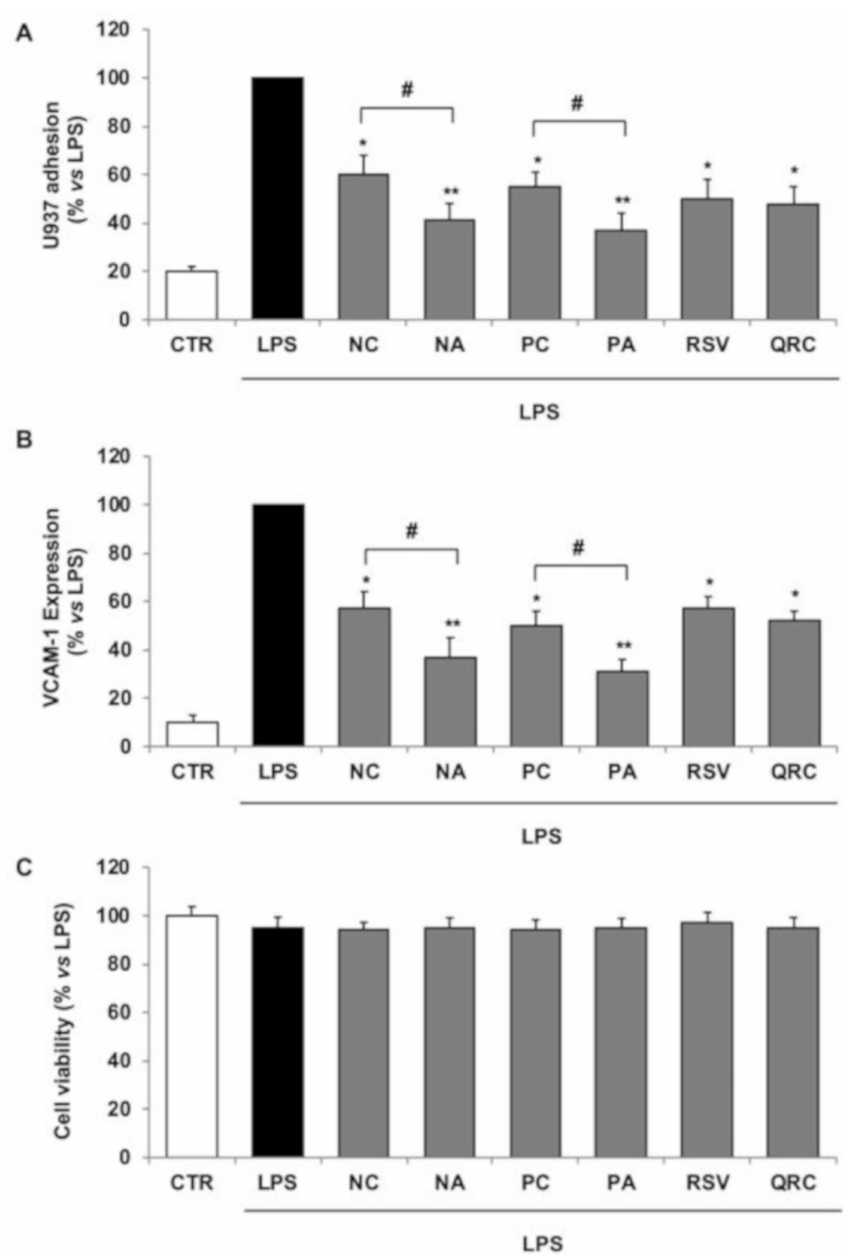
Figure 2. E ff ects of wine polyphenolic extracts or pure polyphenols on endothelial–monocyte adhesion and VCAM-1 expression. HMEC-1 were incubated with blend polyphenolic extracts (NC, PC, NA, PA) (10 µ L), pure polyphenols (resveratrol, RSV; quercetin, QRC) (10 µ mol / L), or vehicle (control, CTR) for 1 h and then stimulated with LPS 0.5 µ g / mL for 16 h. ( A ): HMEC-1 were co-cultured with calcein AM-labeled U937 monocytes. Fluorescence plate reader measured the number of adherent U937 cells. The values of monocyte adhesion are represented in comparison to monocyte adhesion to LPS-stimulated HMEC-1, normalized at 100%. ( B ): Cell surface expression of VCAM-1 was analyzed by cell surface enzyme immune assay (EIA). ( C ): Endothelial cell viability by MTT assay. Each experiment was performed in triplicate. Data are expressed as the percentage of LPS (mean ± S.D.). * p < 0.05; * * p < 0.01 vs. LPS alone; # p < 0.05 NA vs. NC or PA vs.